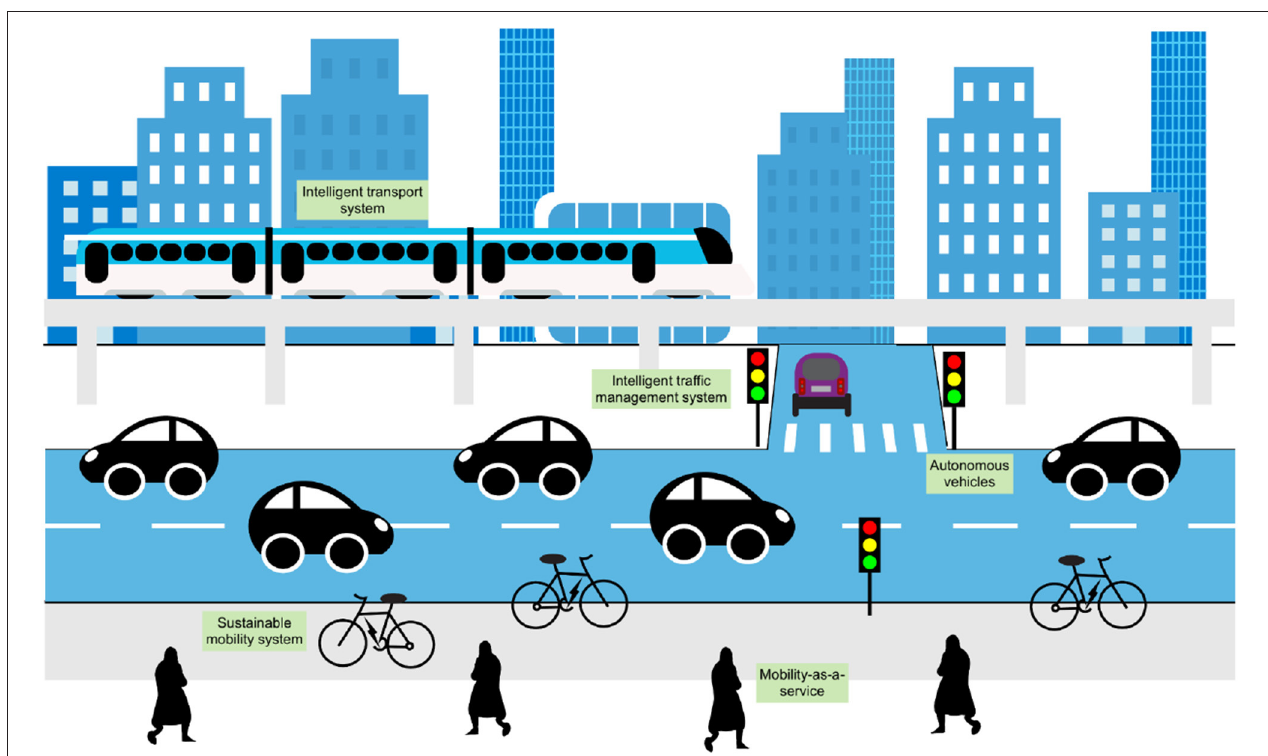
FIGURE 2 | Artificial intelligence-based based urban mobility